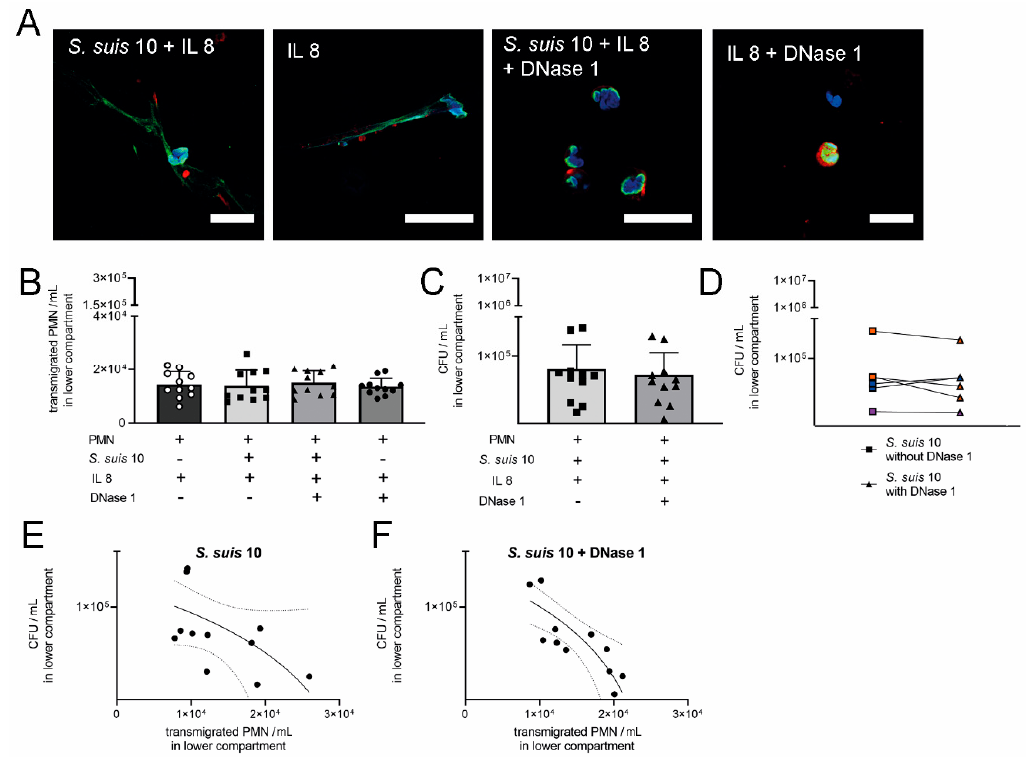
Figure 7. DNase 1 has no impact on transmigration of neutrophils trough a cell layer of PCP-R and killing of S. suis is donor-dependent. ( A ) NET formation was detectable in the CSF compartment in the porcine blood–CSF barrier mimicking physiological conditions in the absence of DNase 1, but was completely destroyed by DNase 1 (blue = DNA (Hoechst); green = DNA / histone-1-complexes (NETs); red = elastase). Representative pictures are shown (scale bar = 20 µ m). ( B ) Transmigration of neutrophils out of fresh porcine blood trough PCP-R was neither significantly influenced by S. suis 10 nor DNase 1. Data shown as mean ± SD, n = 6 independent experiments with five duplicates and once a single value. Statistical analysis one-way ANOVA. ( C ) Killing of S. suis 10 in CSF was not significantly influenced by transmigrated neutrophils in presence of DNase 1. Statistical analysis: unpaired Student’s t -test. Data shown as mean ± SD, n = 6 independent experiments with five duplicates and once a single value. ( D ) Values from one experiment, with blood from the same donor pig, without and with DNase 1 in the CSF compartment are connected by a line. A donor-dependent influence regarding the e ff ect of DNase 1 on killing e ffi ciency is detectable (orange = DNase 1 reduces CFU; blue = DNase 1 increases CFU; violet = DNase 1 no impact on CFU). ( E ) Correlation of transmigrated neutrophils and S. suis 10 in CSF. The more neutrophils transmigrate into the CSF, the higher is the killing of the bacteria. Statistical analysis: Pearson correlation r = − 0.5. ( F ) Correlation of transmigrated neutrophils and S. suis 10 + DNase 1 in CSF. With DNase 1 the Pearson correlation r = − 0.8 is significant, p = 0.0026. E and F are calculated based on data from B and